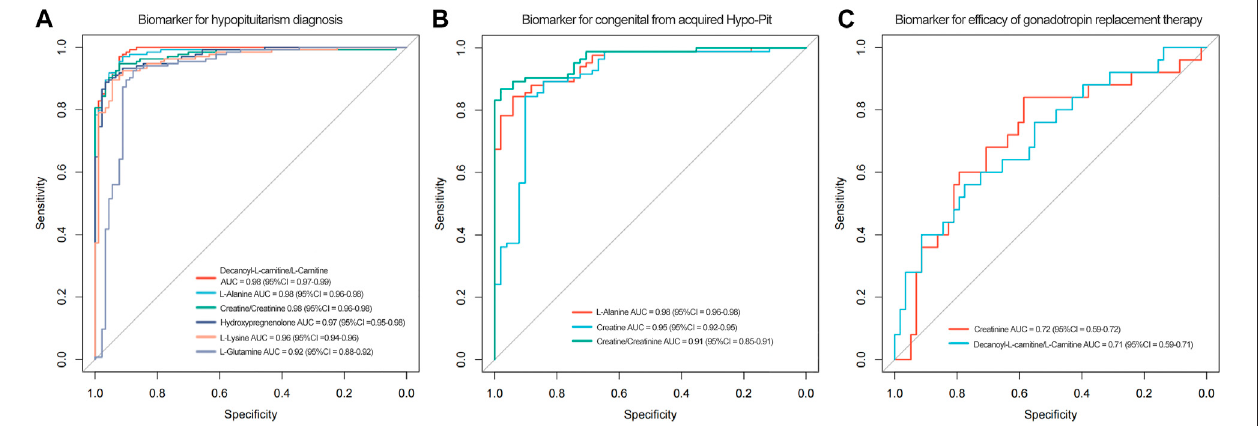
FIGURE 6 | Figure 6A . The ROC curves of decanoylcarnitine/L-carnitine ratio, L-alanine, creatine/creatinine ratio, hydroprenenolone sulfate, L-lysine and L-glutamine for hypopituitarism diagnosis. Figure 6B. ROC curves of serum L-alanine, creatine and creatinine for discrimination of congenital from acquired Hypo-Pit patients. Figure 6C. ROC curves of creatinine and decanoylcarnitine/L-carnitine for ef fi cacy of gonadotropin replacement